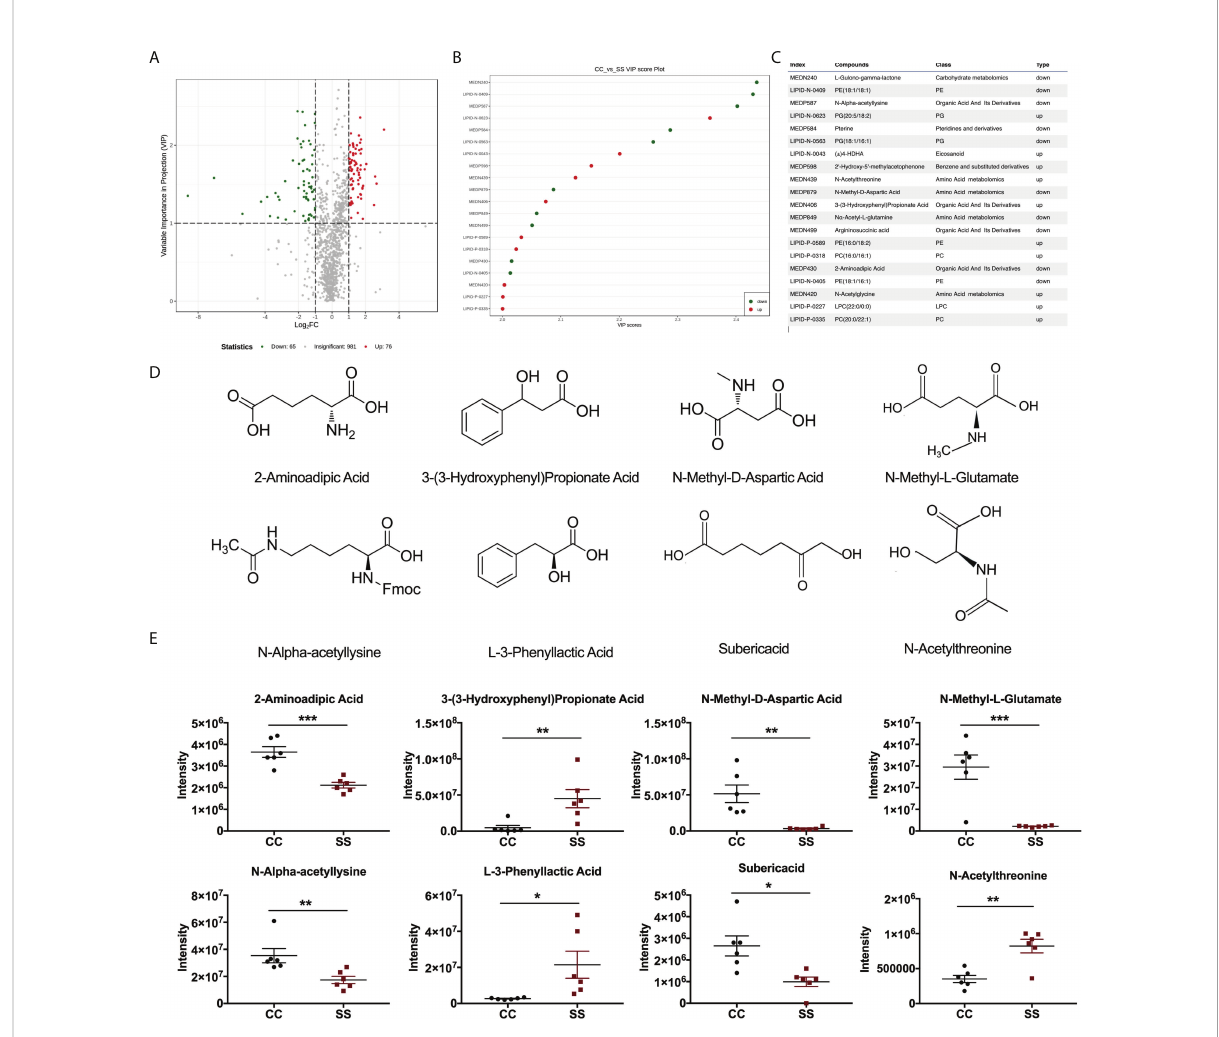
FIGURE 4 Anesthesia/surgery induced changes in metabolites in rats with preoperative stress (A) Volcano plot of differential metabolites in fecal samples from CC and SS rat group (n = 6/group). (B) Variable importance in projection (VIP) score plot of differential metabolites in fecal samples from CC and SS rat group (n = 6/group). (C) Part of the index numbers and corresponding metabolite compounds were detected in this experiment. (D) Structures of 2-aminoadipic acid, 3-(3-sulfooxyphenyl)propanoic acid, N-methyl-D-aspartic acid, N-methyl-L-glutamate, N-alpha-acetyl- lysine, L-3-Phenyllactic acid, suberic acid, and N-acetylthreonine. (E) Relative abundances of 2-aminoadipic acid, 3-(3-sulfooxyphenyl) propanoic acid, N-methyl-D-aspartic acid, N-methyl-L-glutamate, N-alpha-acetyl-lysine, L-3-Phenyllactic acid, suberic acid, and N- acetylthreonine in fecal samples from CC and SS rat group (n = 6/group). An unpaired t-test was used for normally distributed data and the Mann-Whitney U test was used for non-normally distributed data. Data represent mean ± SEM. * P< 0.05, ** P< 0.01, *** P< 0.001 vs SS group. CC, no stress; SS, preoperative stress and anesthesia/surgery